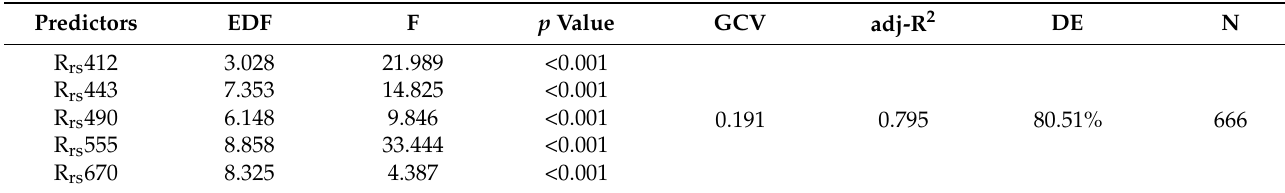
Table 3. Statistical summary of the fitted Micro GAM.